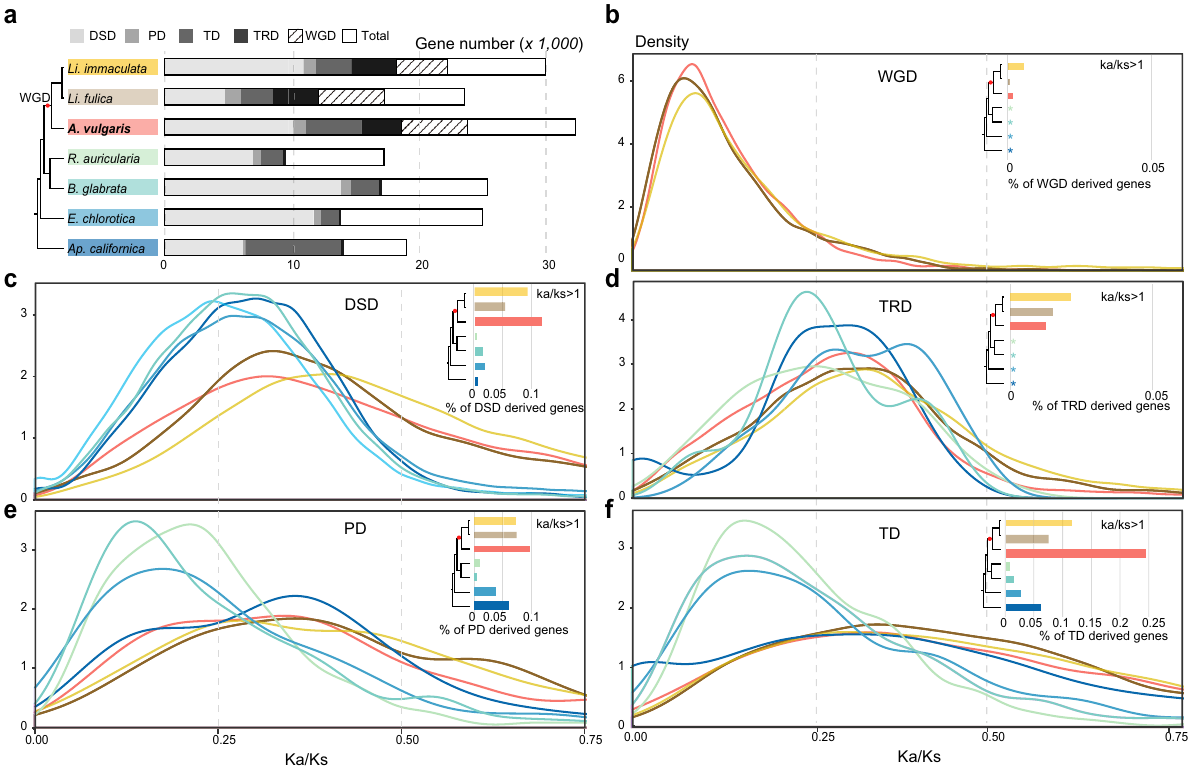
Figure 4. Gene duplication and evolution in Heterobranchia species. ( a ) The number of gene pairs derived from different modes of duplication. ( b–f ) The Ka / Ks ratio distributions of gene pairs derived from different modes of duplication in different species. Bar graphs show the proportion of positively selected genes ( Ka / Ks > 1) that were duplicated by different mechanisms. Colors represent different species. WGD, whole- genome duplication; TD, tandem duplication; PD, proximal duplication; TRD, transposed duplication; DSD, dispersed duplication; Total, total annotated